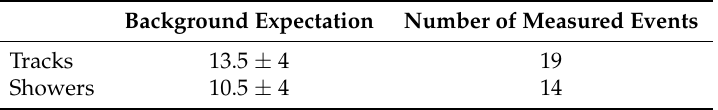
Table 1. Astronomy with a Neutrino Telescope and Abyss environmental RESearch (ANTARES) diffuse flux analysis: number of selected events after quality cuts for track and shower channel. Expected number of background and signal events are also